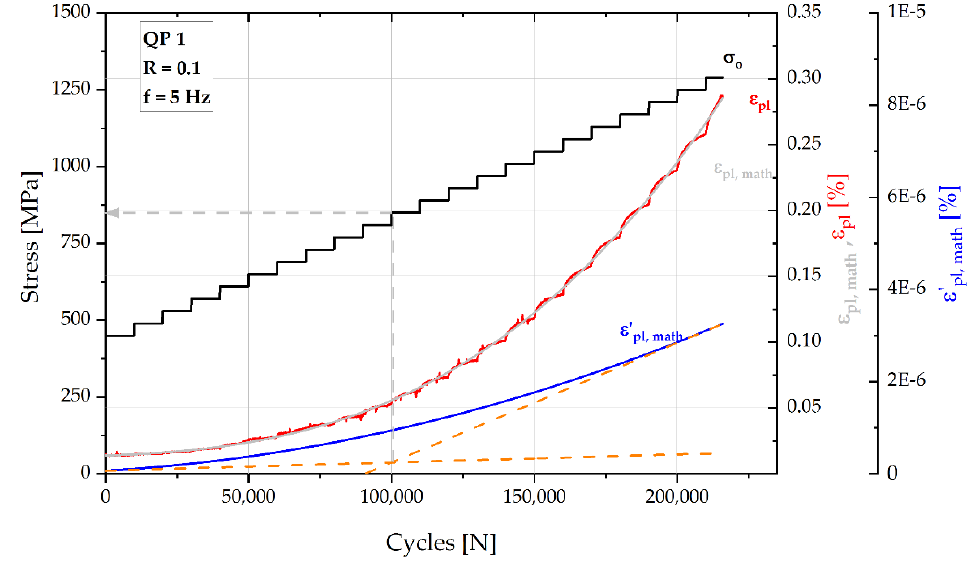
Figure 8. Load Increase Test for the QP1 condition. The maximum stress at failure is about 1290 MPa and occurs after about 216,000